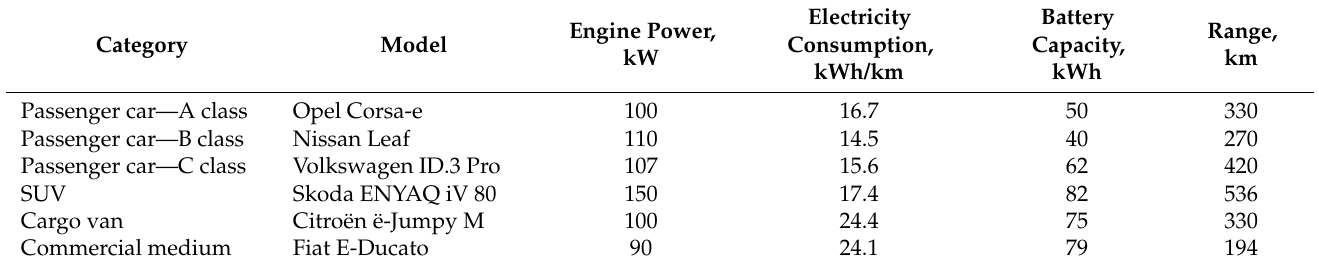
Table 2. Specification of battery electric